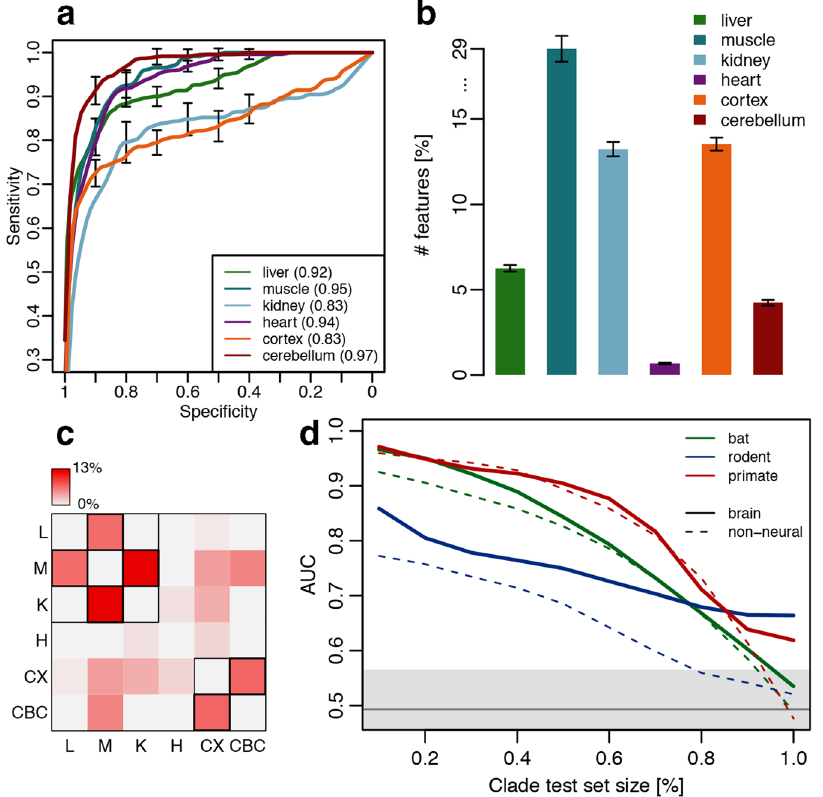
Figure 2. Long lifespan prediction. ( a ) Accuracy of predictive models in each tissue. ( b ) Proportion of lipid compounds identified as MLS predictors in each tissue. ( c ) Proportion of MLS predictors shared between tissues. Black borders indicate significant overlap (p < 0.05). ( d ) AUC of predictive models, constructed on training sets excluding an increasing proportion of randomly sampled individuals of one clade, with the models’ accuracy, tested on the clade individuals excluded from the training set. Identity of the test clade is indicated by the curve color. The horizontal gray line and shaded region represent mean and standard deviation of the random predictor accuracy calculated by randomizing the output variable 100